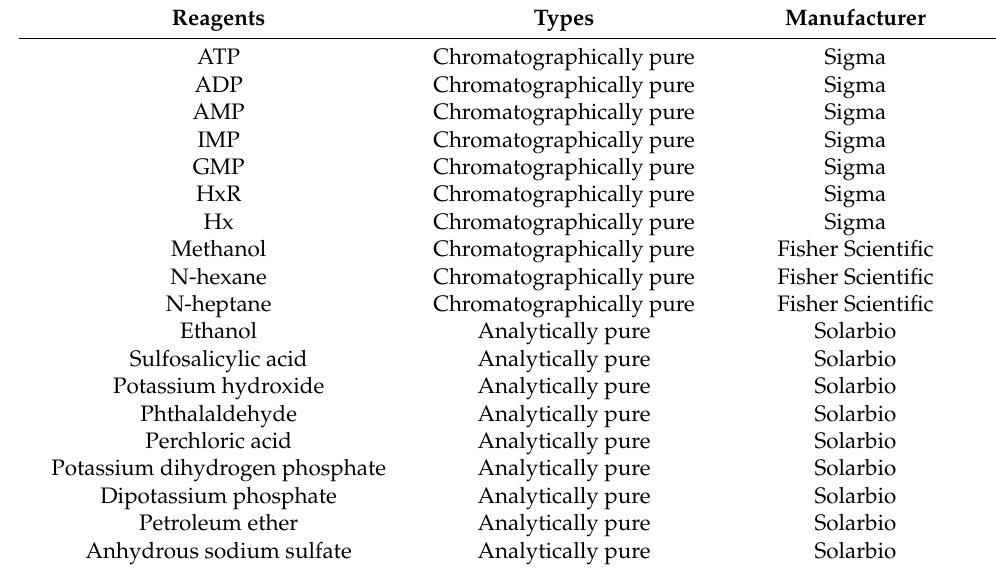
Table 1. List of reagents and solvents used.